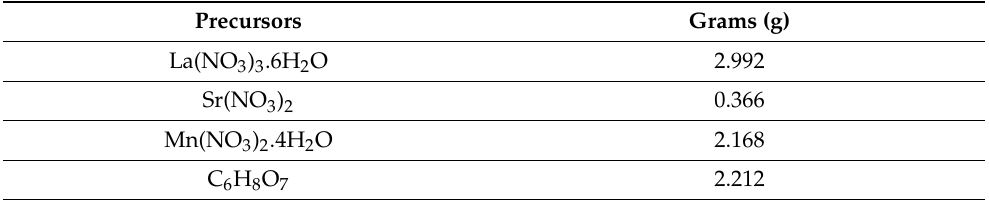
Table 4. Preparation parameters of La 0.6 Sr 0.4 MnO 3.